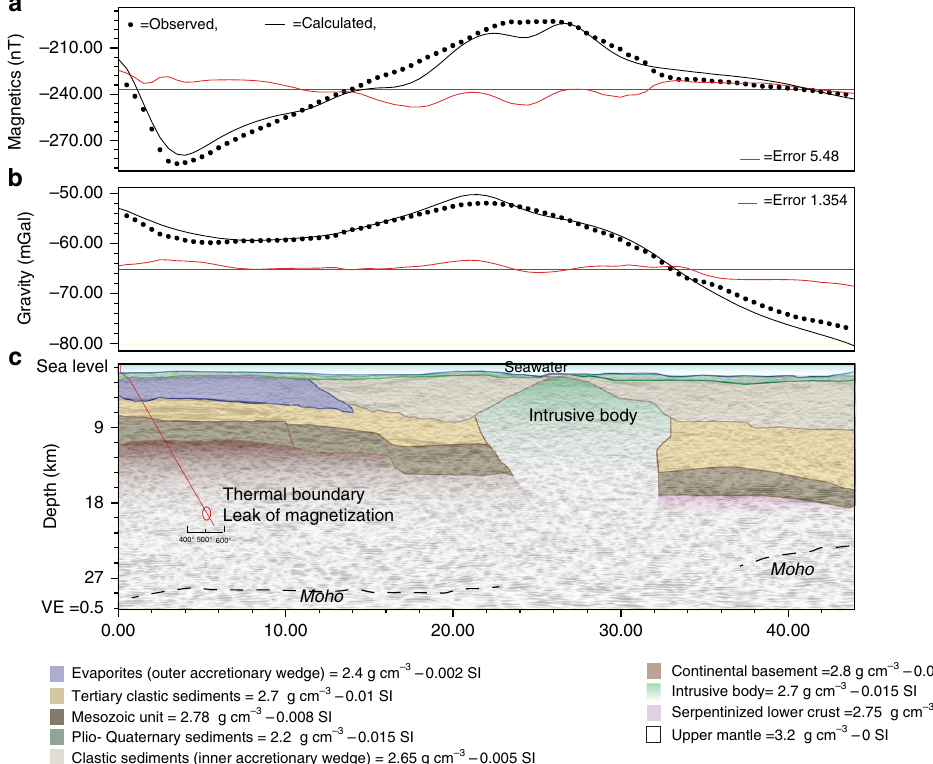
Fig. 4 Forward magnetic and gravity modeling. a Observed, calculated, and mis fi t (error) curves for magnetic modeling along seismic line CA-A (Fig. 3b). b Observed, calculated, and mis fi t (error) curves for gravimetric modeling along seismic line CA-A (Fig. 3b). c Geometry of causative rocks derived from depth-migrated seismic section used as background. Average fi tting errors were 5.48 nT (5.5 %) and 1.354 mGal (2.5 %), for magnetic and gravity pro fi les, respectively. Red line identi fi es the depth distribution of the local geothermal